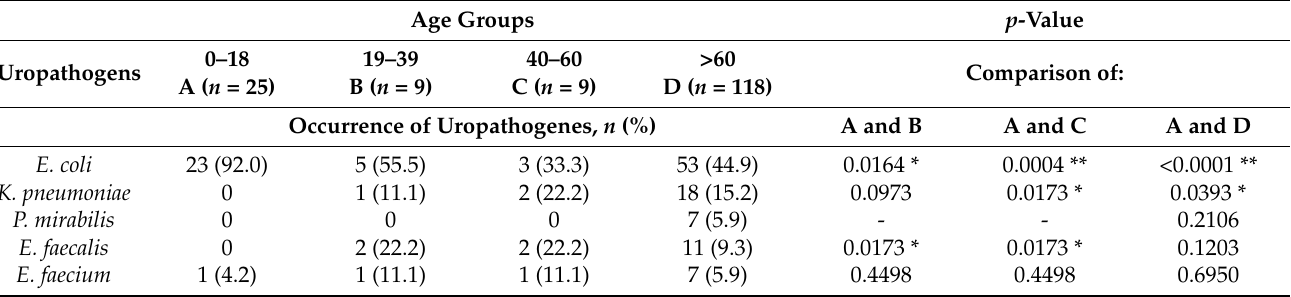
Table 4. The prevalence of major uropathogens in different age groups of hospitalized patients.